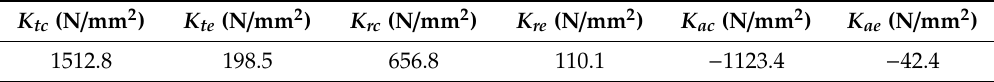
Table 3. Milling force coe ffi cients of 50 HRC hardened steel.